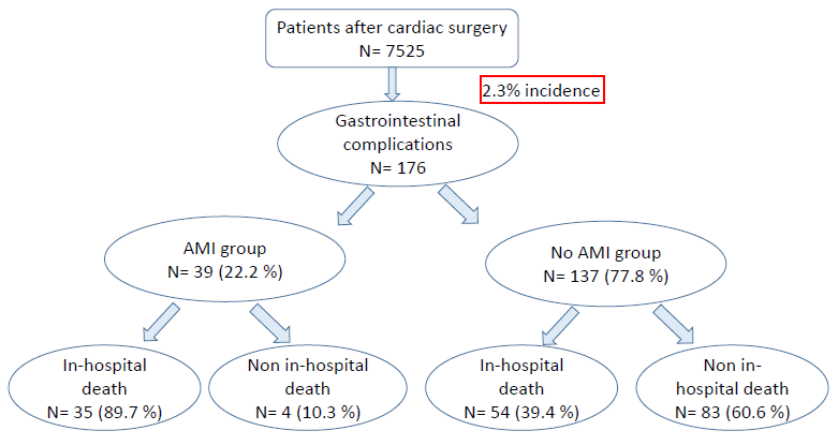
Figure 1. Summarizing plot of patients with gastrointestinal complications after cardiac surgery.